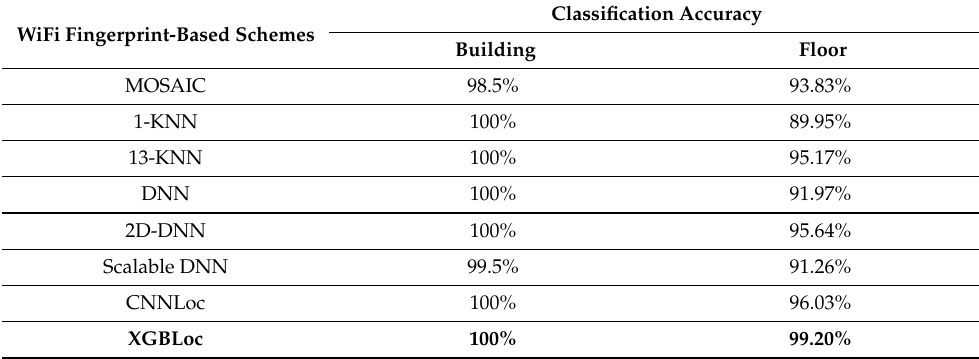
Table 7. Classification results of existing and proposed schemes on the UJIIndoorLoc dataset.